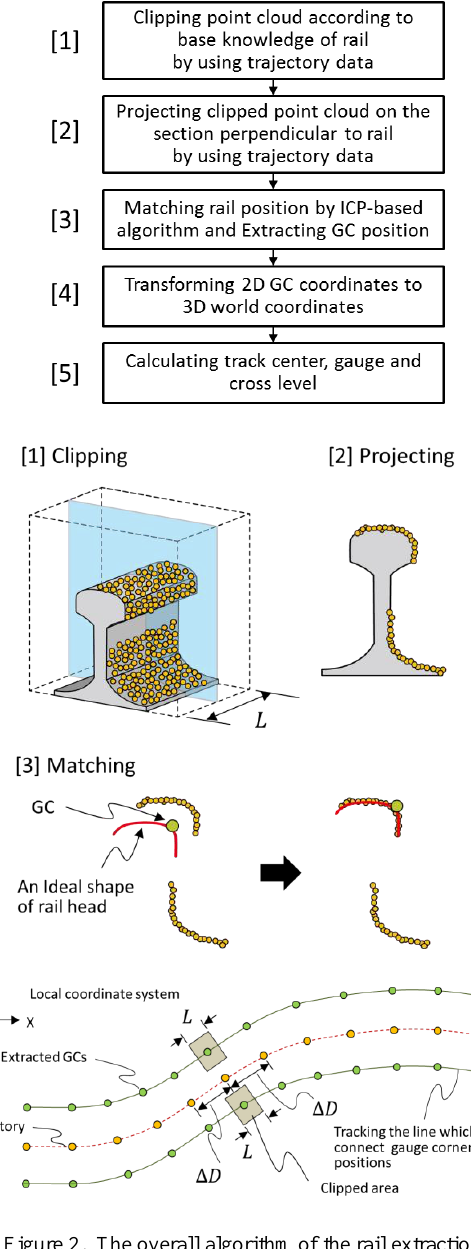
Figure 2. The overall algorithm of the rail extraction